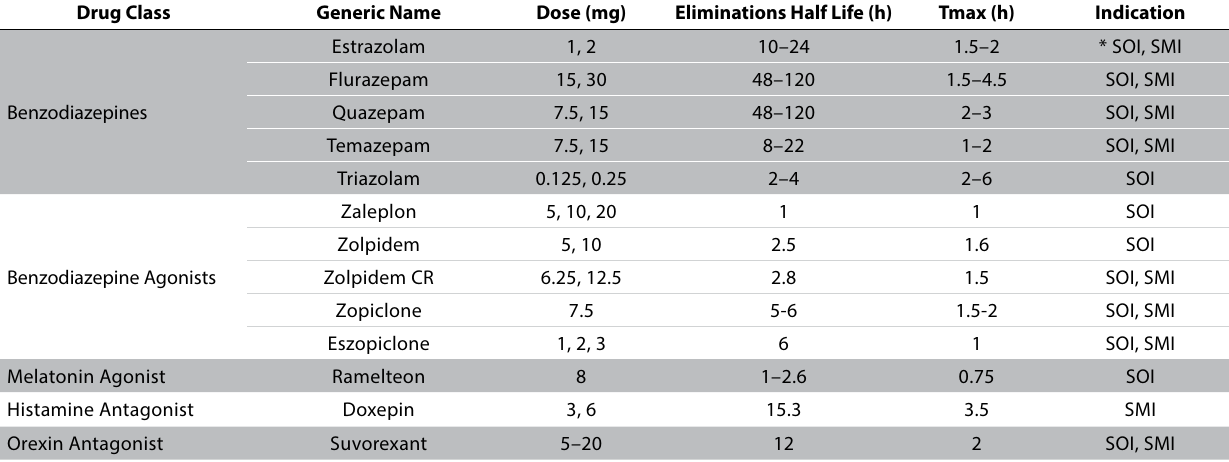
Table 3. Summary of hypnotics for insomnia 55 Drug Class